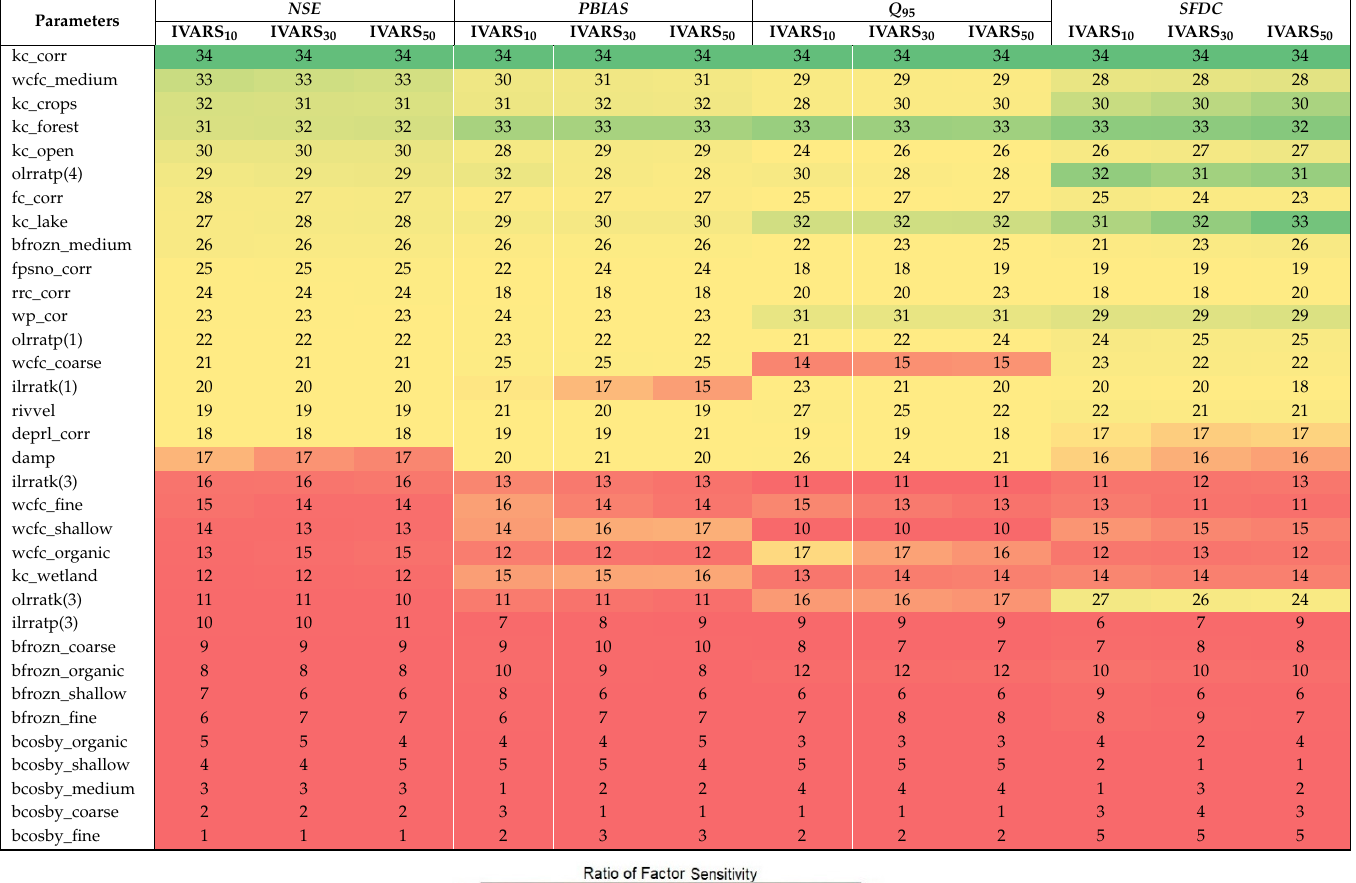
Table 4. Comparison of the ranking of model parameters based on maximum ratio of factor sensitivity (RFS), from most influential (green) to least influential parameter (red) determined from time variant sensitivity analysis (TVSA) on 30-day window period (IVARS 50 ), and monthly SA using different evaluation metrics.